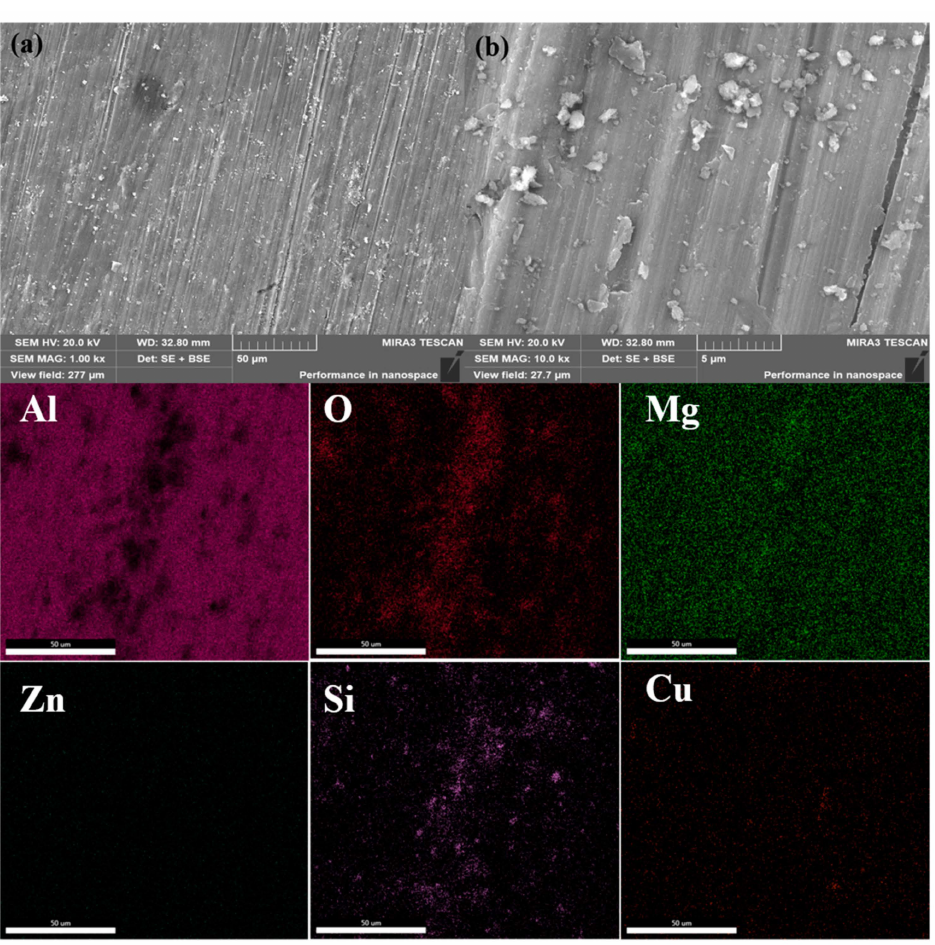
Figure 6. SEM image ( a , b ) and EDS mapping of 7075 aluminum alloy after corrosion in add SRB real